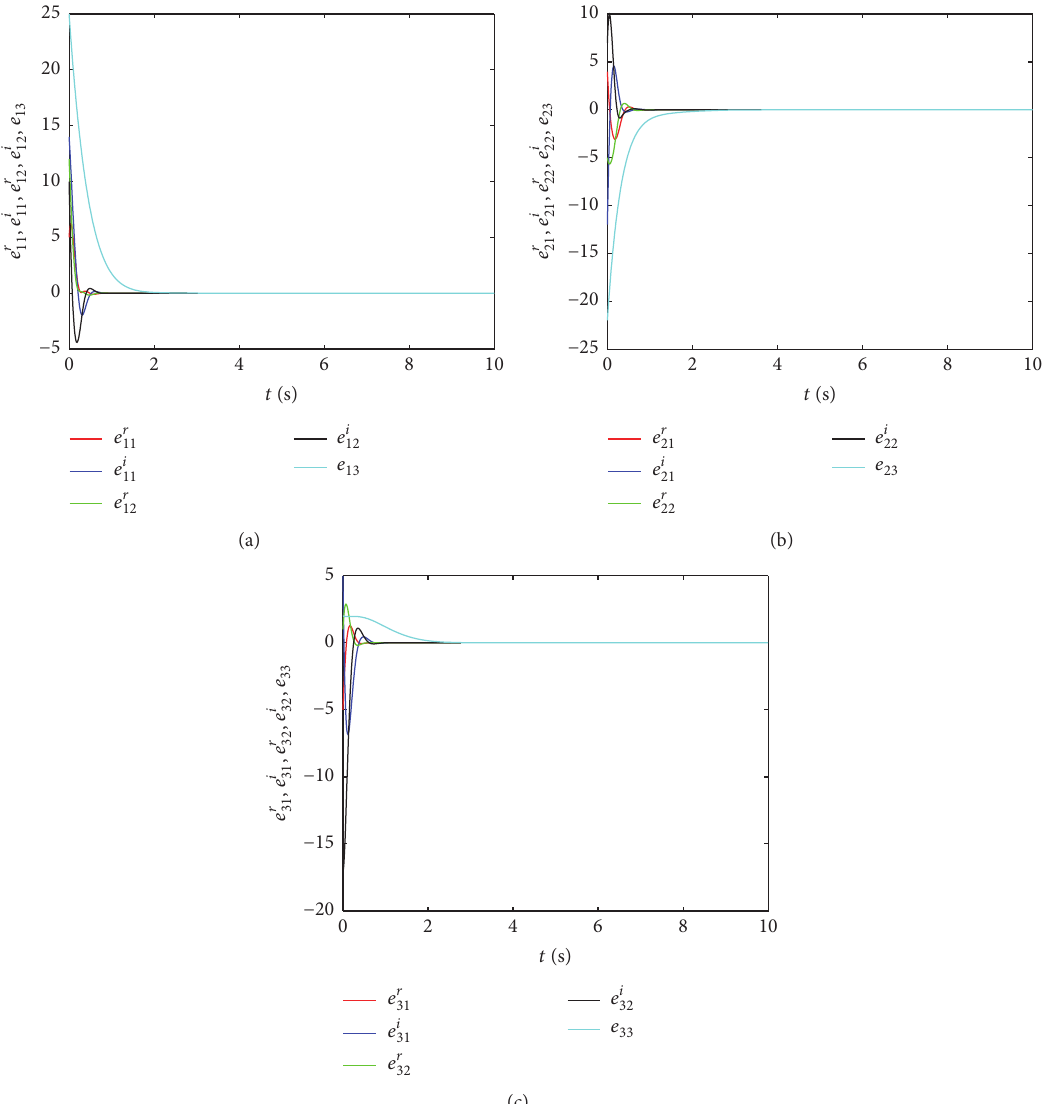
Figure 4: The error dynamics of synchronization among 4 -coupled complex PMSM